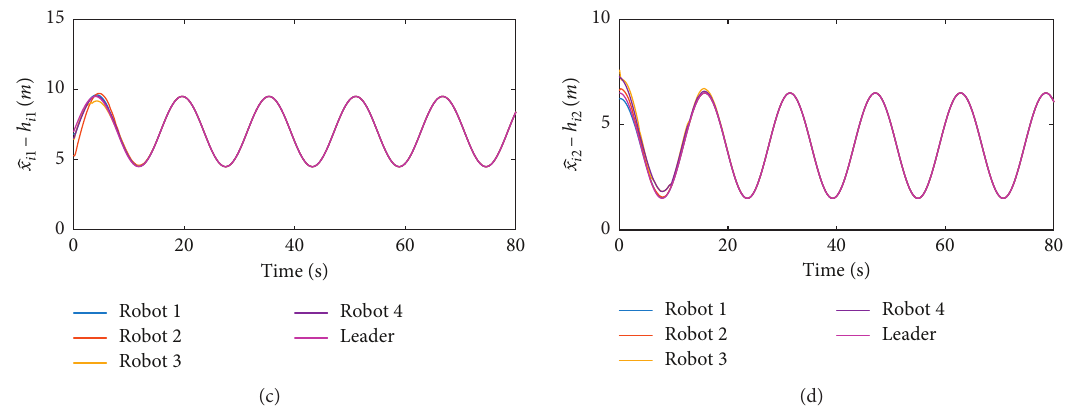
Figure 4: Evolution of x